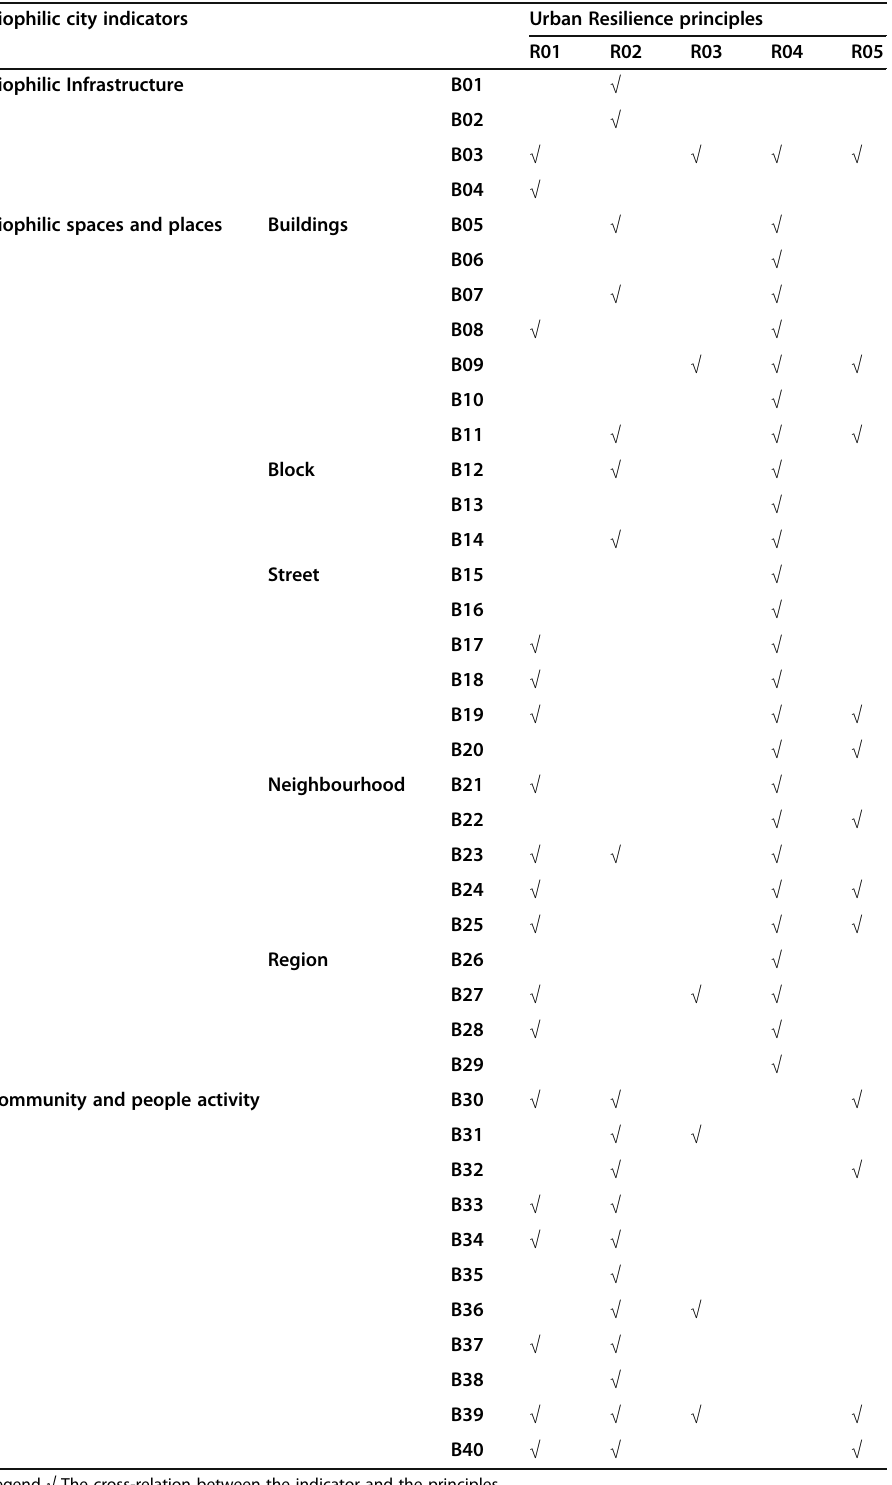
Table 5 Mapping relationship between biophilic cities indicators and principles of urban resilience (Authors)